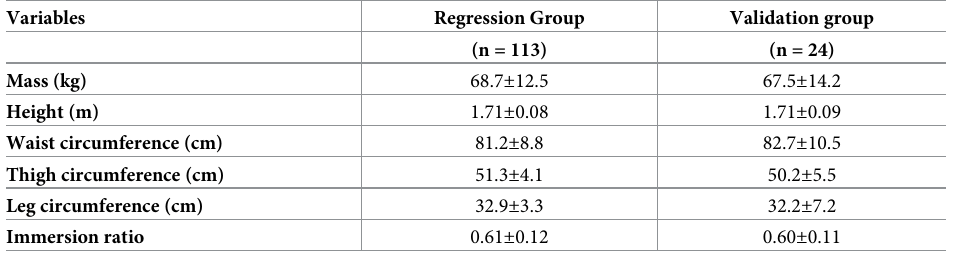
Table 1. Mean and standard deviations of mass, height, circumferences and immersion ratio for the validation and regression groups.